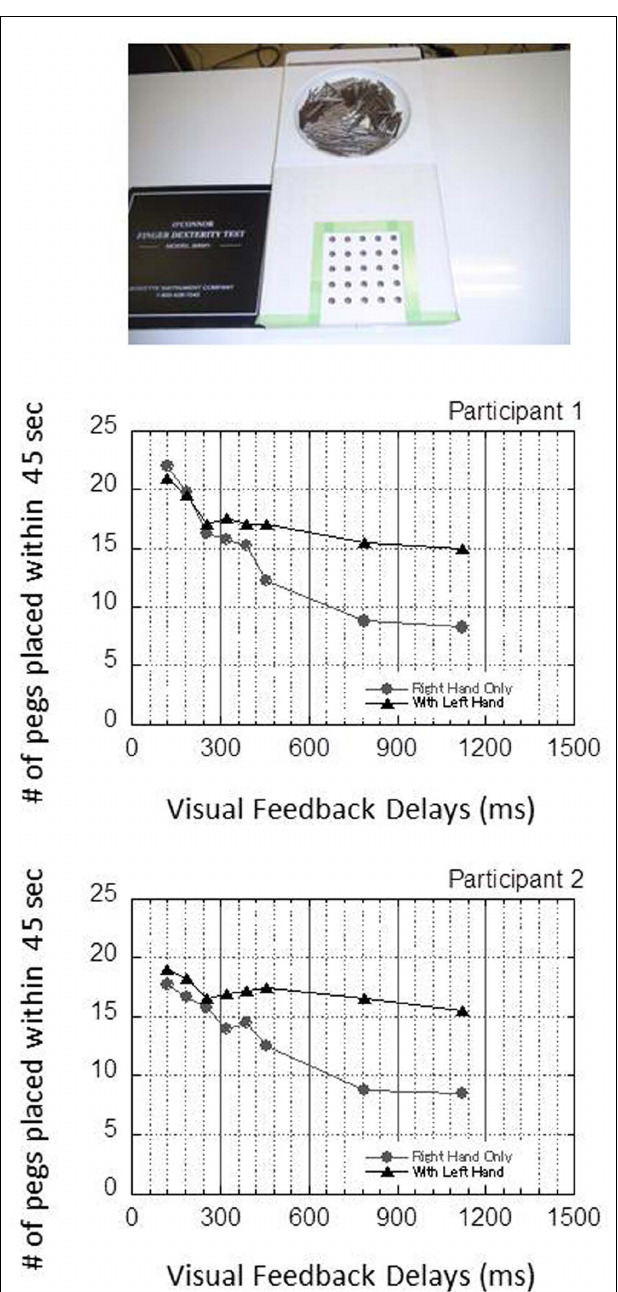
FIGURE 9 |An additional experiment using the O’Connor Finger DexterityTest, whose apparatus has round-shaped holes and therefore no orientation components, was performed to check whether the amelioration of disruption by using the left hand found in experiment 2 can be explained by the effect of orientation information provided from tactile–tactile, within-modal matching. In this experiment, the number of holes was restricted to 25, and the length of each trial to 45s.The results showed that the overall tendency was similar to that in the Grooved Pegboard test even when no orientation information was provided, suggesting that the tactile–tactile orientation matching may not fully explain the amelioration of performance in the second, third, and fourth